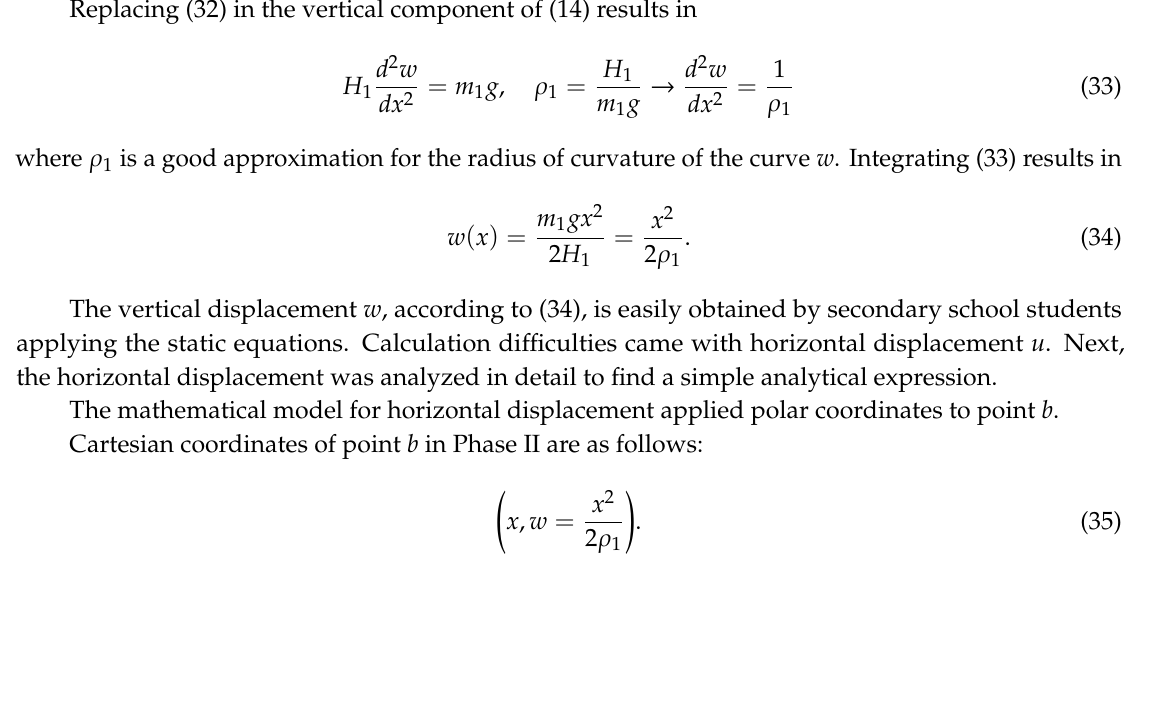
Figure 4. Differential elements in Phase II (lifting). Right segment AB of the final parabola. Figure 4. Di ff erential elements in Phase II (lifting). Right segment AB of the final